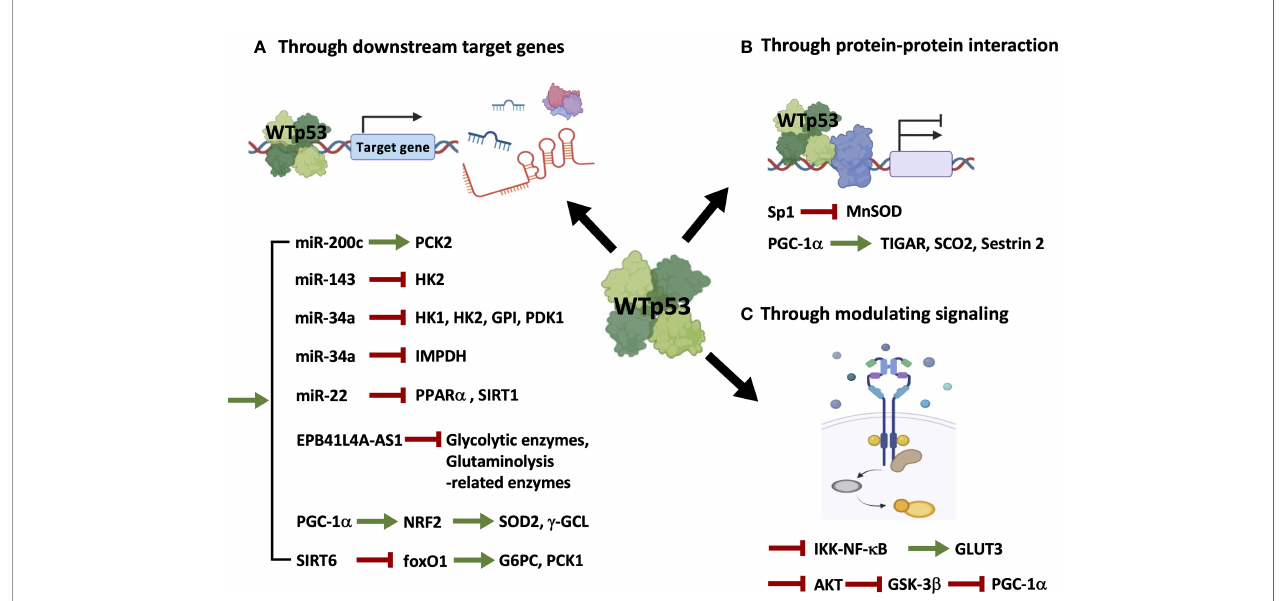
FIGURE 1 | Wild-type p53 regulates cellular metabolism through indirect mechanisms. WTp53 indirectly regulates metabolism through inducing its direct targets, including miRNAs, lncRNAs, and proteins (A) , associating with other transcription factors (B) , or modulating signaling pathways (C)